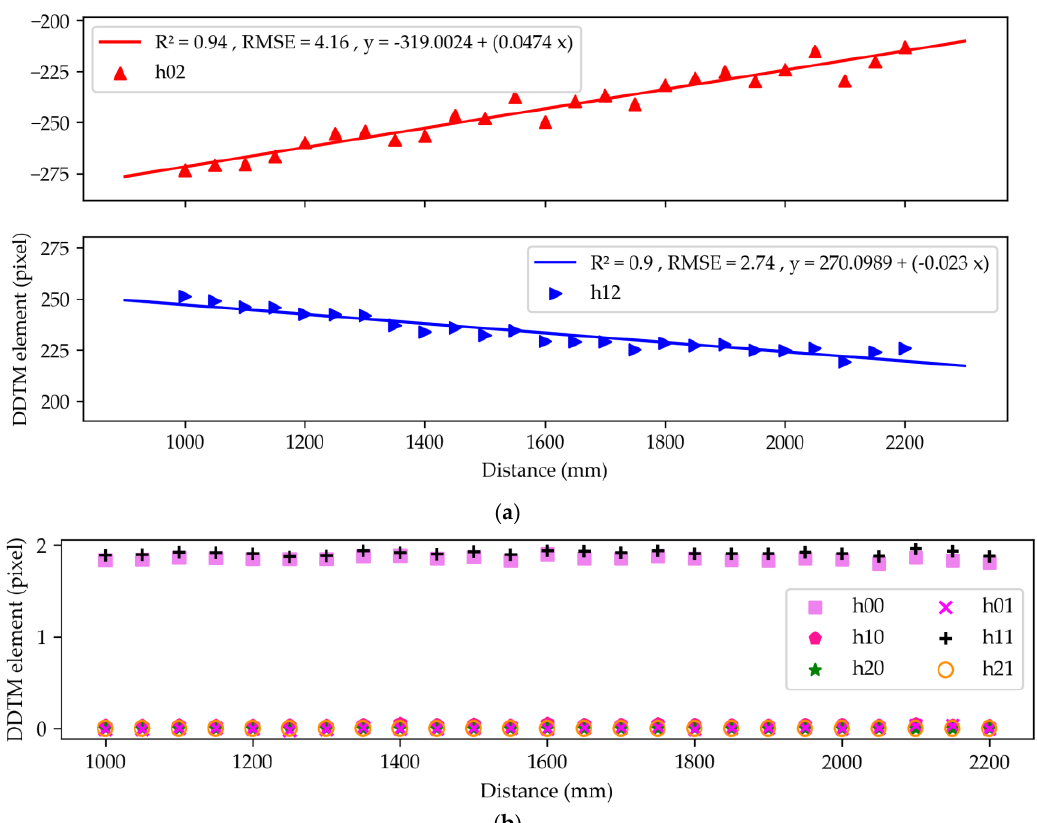
Figure 4. Relations between the distance of the target and the coefficients of the distance-dependent transformation matrix (DDTM) of the homography between the thermal slave image and the 800-nm master image: ( a ) distance-dependent coefficients; ( b ) distance-independent coefficients.